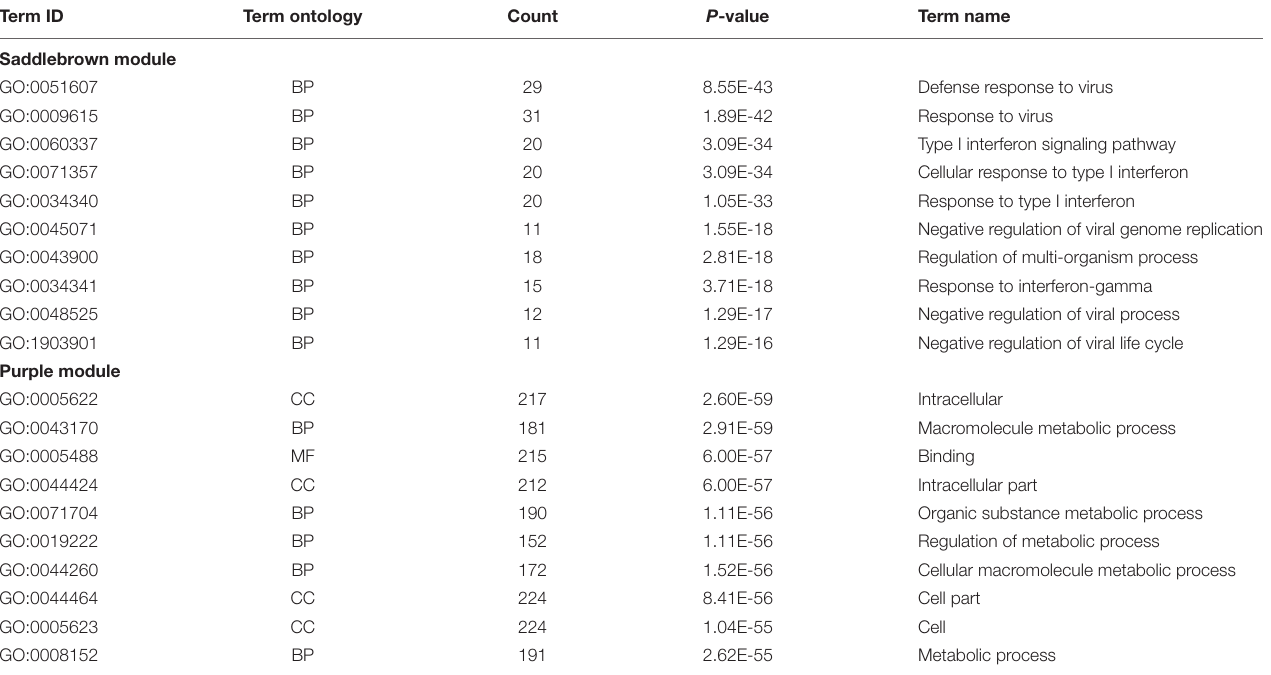
TABLE 3 | GO enrichment analysis of genes in co-expression modules.